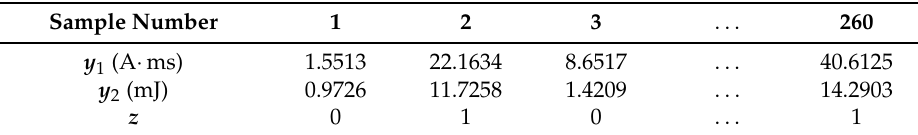
Table 2. The sample set of typical